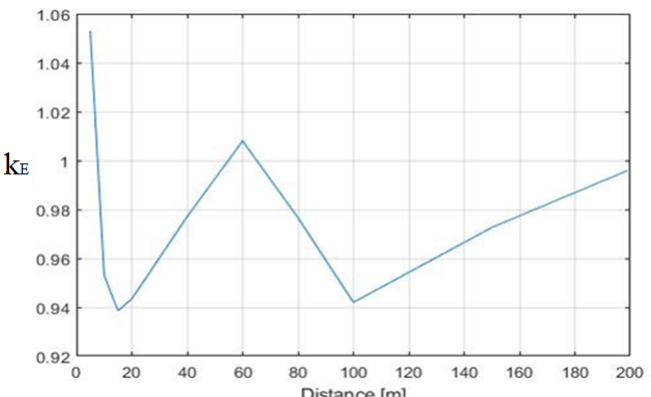
Figure 3. Ratio between the maximum value of the electric field with and without the building. (A) H = 20 m, and d varies from 5 to 200 m.